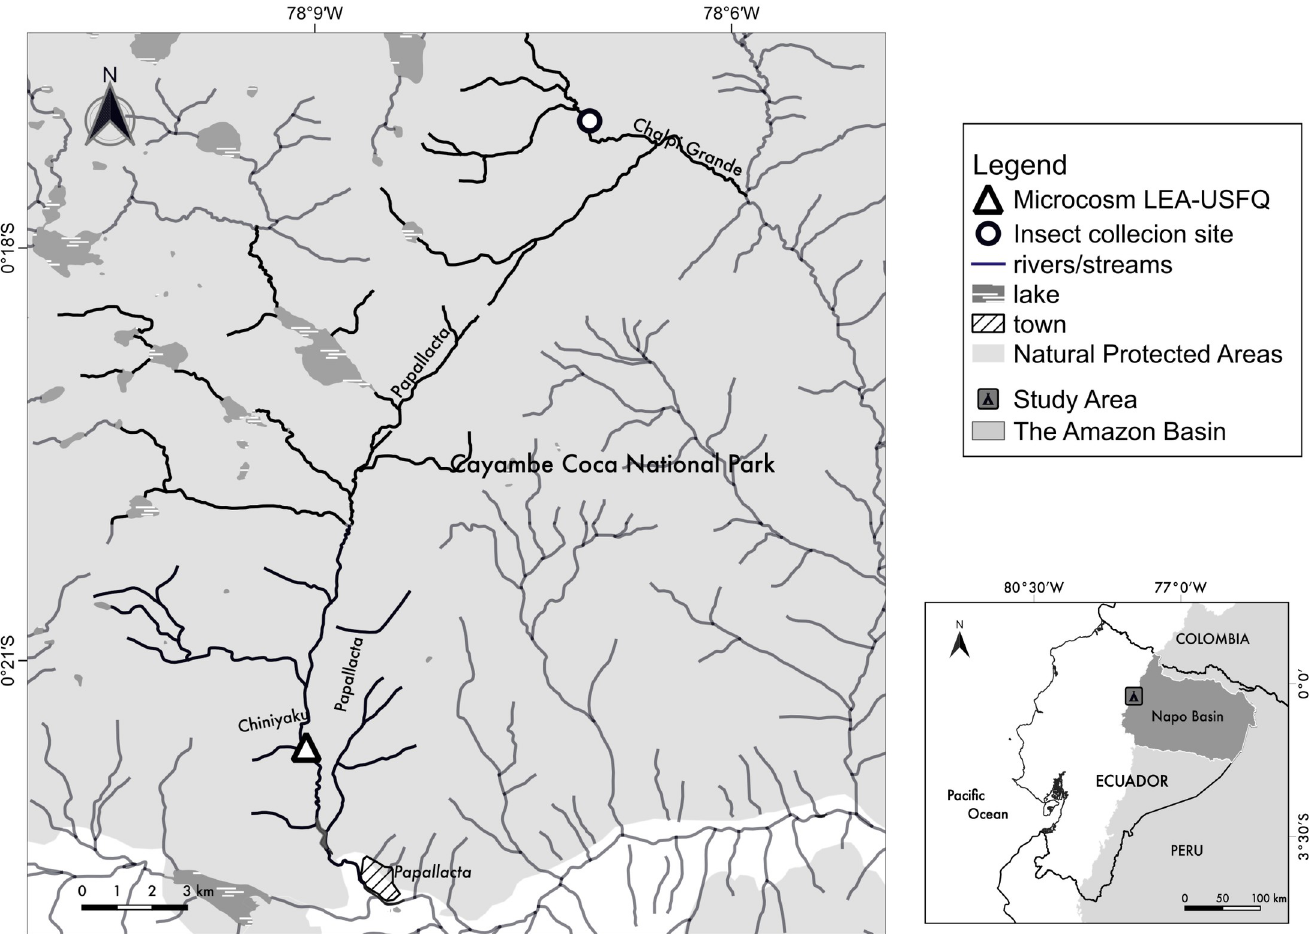
Fig 3. Experimental facility located in the Papallacta region, Napo Province, Ecuador. Insect collection site in the Cayambe Coca National Park and location of the microcosm facility. The rivers and streams in this area are part of the Napo subbasin, Amazon Basin.